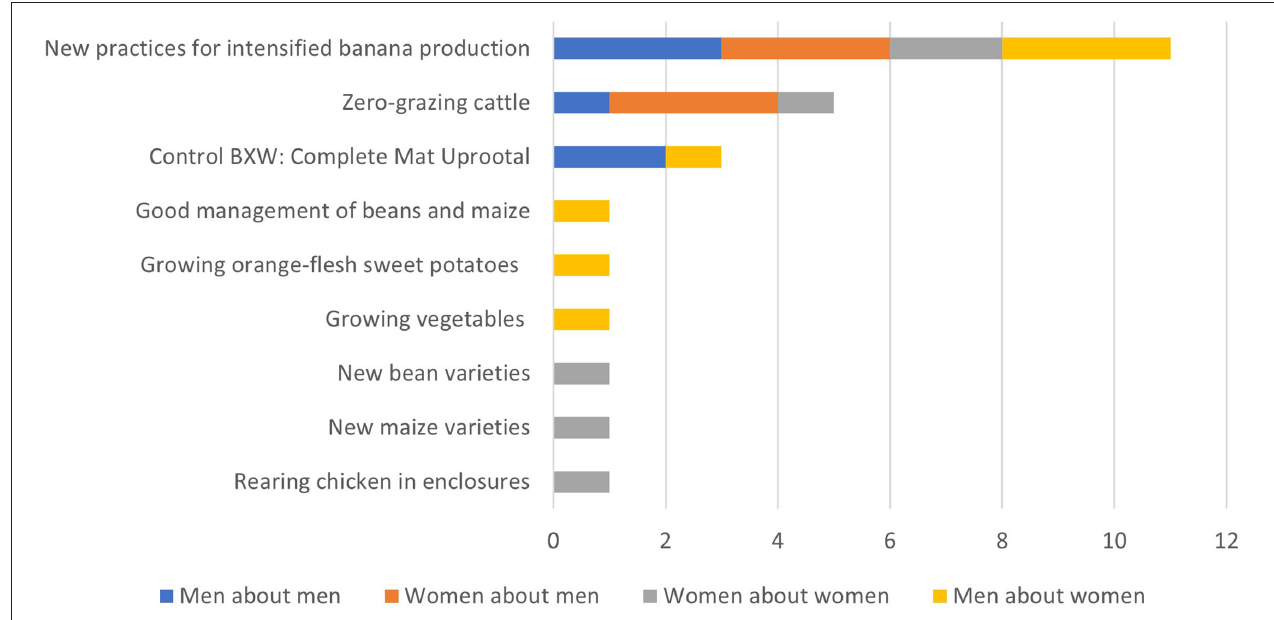
FIGURE 2 | Most important innovations of the past 10 years as identified and listed in six single-sex FGDs (3M, 3F). On x -axis the number of FGDs in which the innovation was listed as most important innovation for members of the own sex and/or for the opposite sex in the selected parish, Isingiro district,